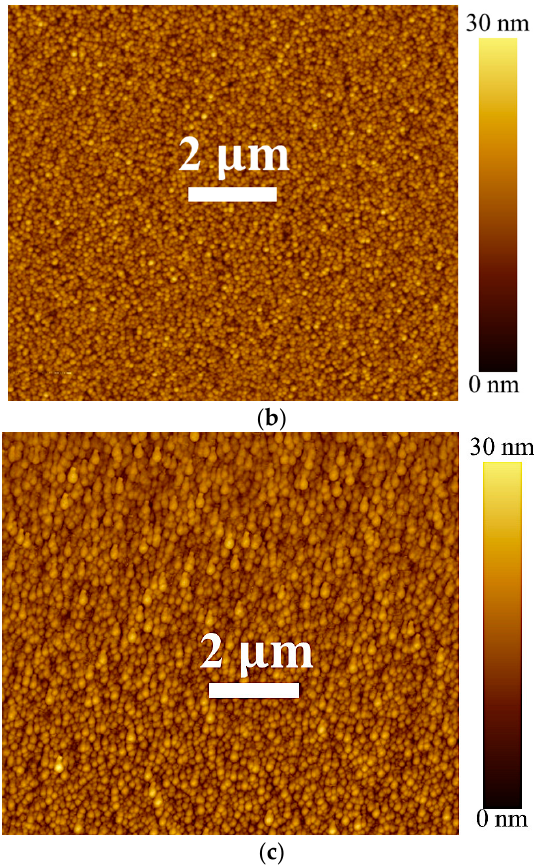
Figure 5. Atomic force microscopy (AFM) images of ZnO SLs annealed in ( a ) vacuum; ( b ) air, and ( c ) Nitrogen ambient.